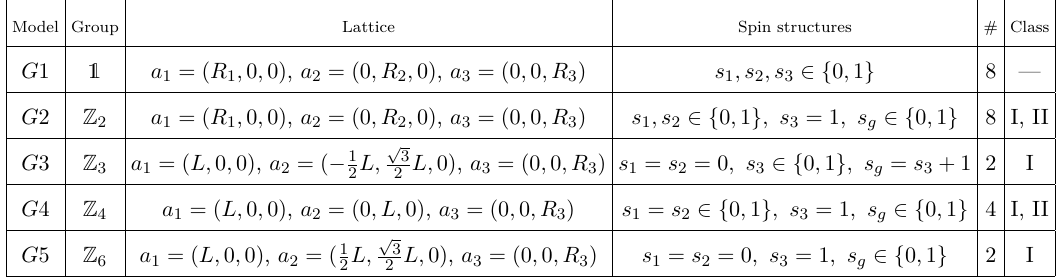
Table 1. Spin structures on ( T 2 × S 1 ) / Z N . s i = 0 and s i = 1 correspond respectively to periodic and anti-periodic spin structures along the a i cycles, whereas s g appears in the lift of the rotation by 2 π/N to Spin (3) . For class I models ( s 1 , s 2 ) = (0 , 0) , while ( s 1 , s 2 ) 6 = (0 , 0) for class